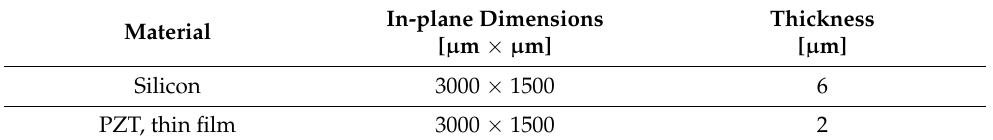
Table 2. Geometrical features of the cantilever